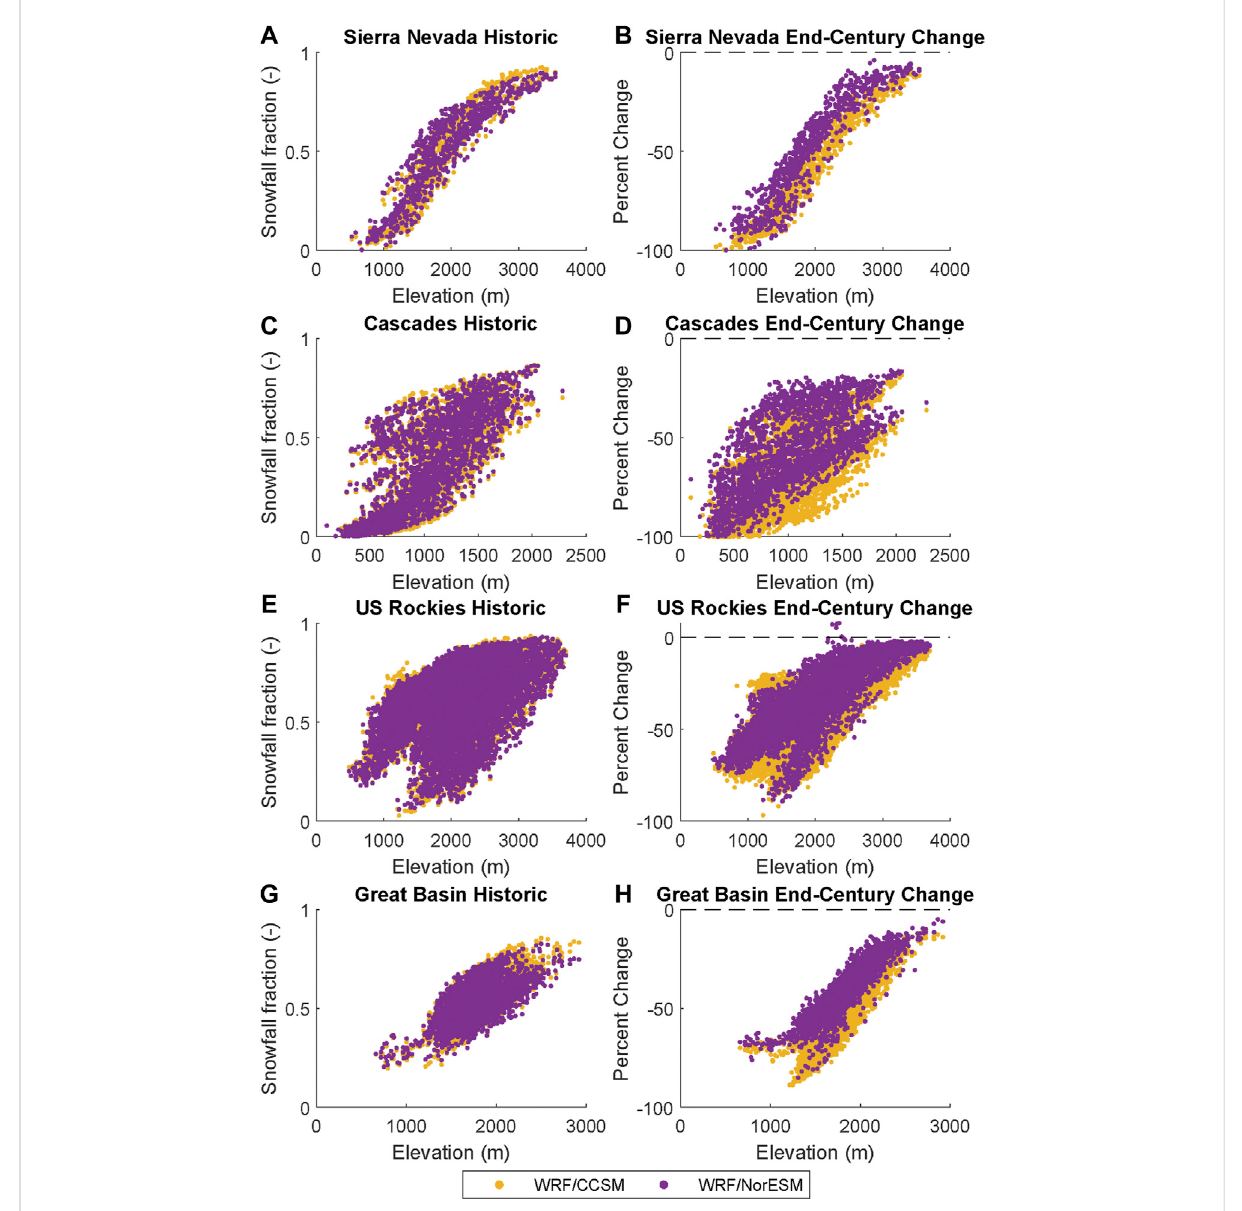
FIGURE 6 (A,C,E,G) Relationship between snowfall fractionandelevationfor individual gridcellswithin fourmountain rangesinthewesternUnited